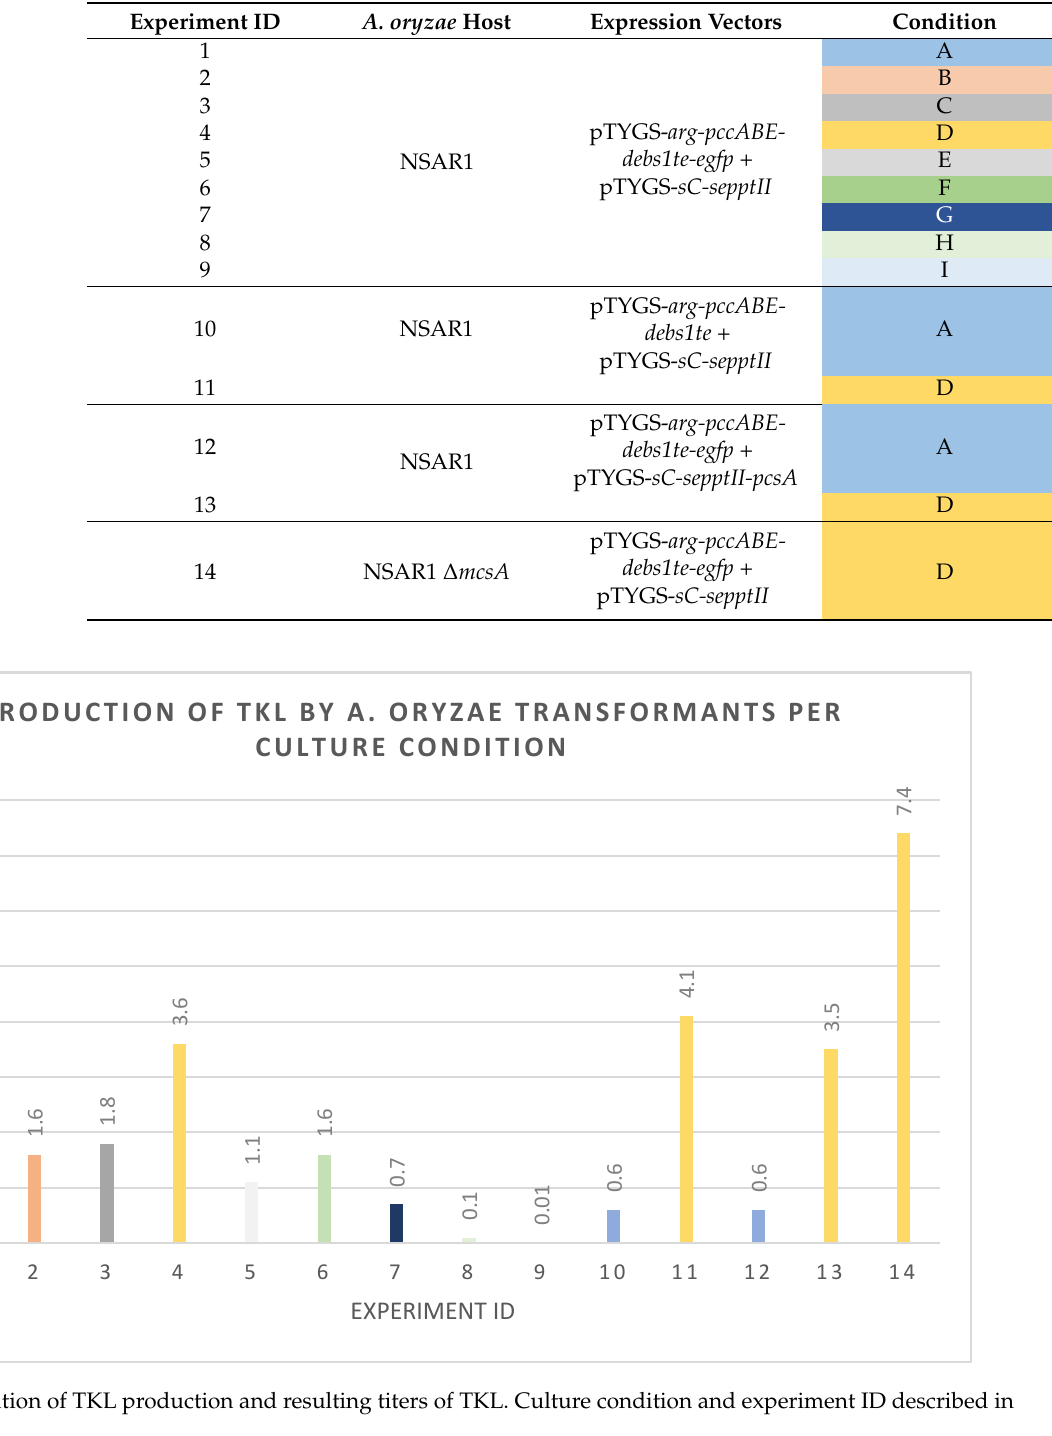
Table 2. Description of different feeding experiments perfomed on various A. oryzae host strains.